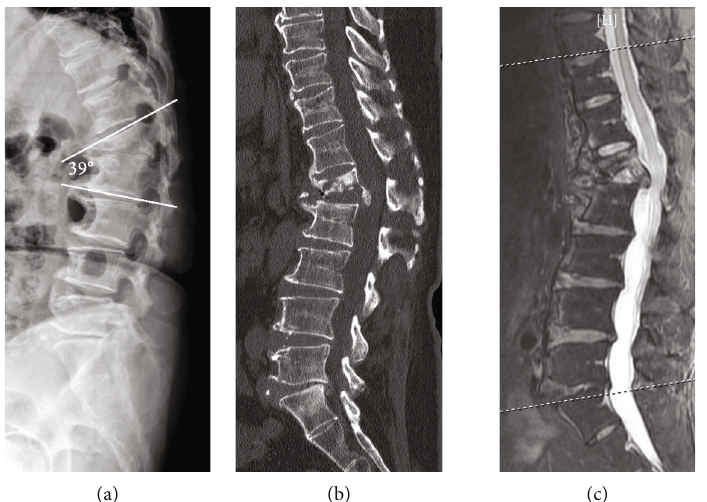
Figure 3: (a) Lateral radiographs showed a collapsed nonhealed L1 fracture and local kyphosis (39 degrees). Sagittal CT (b) and MRI (c) show a retropulsed bone fragment which compromised the spinal canal.